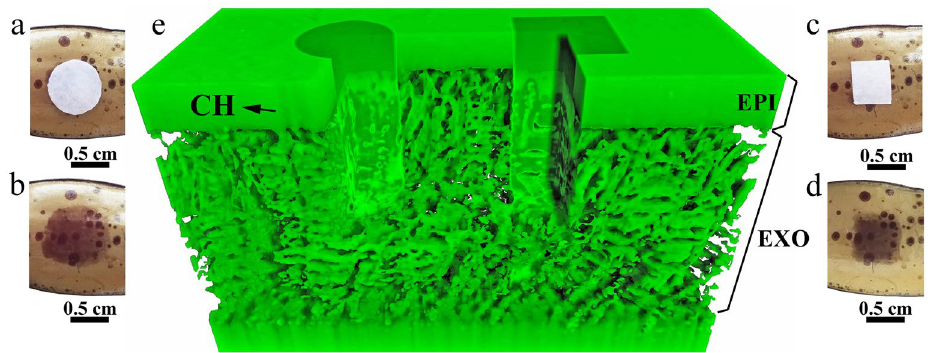
Figure 2. Dynastes tityus elytron infiltrated with water from circular ( a ) and square ( c ) wet papers. Local color changes occurred in corresponding circular ( b ) and square ( d ) shapes, which were included in the three- dimensional reconstruction of the microstructure in the FIB-SEM results ( e ) three-dimensional structure of microstructure additional details revealed by FIB.